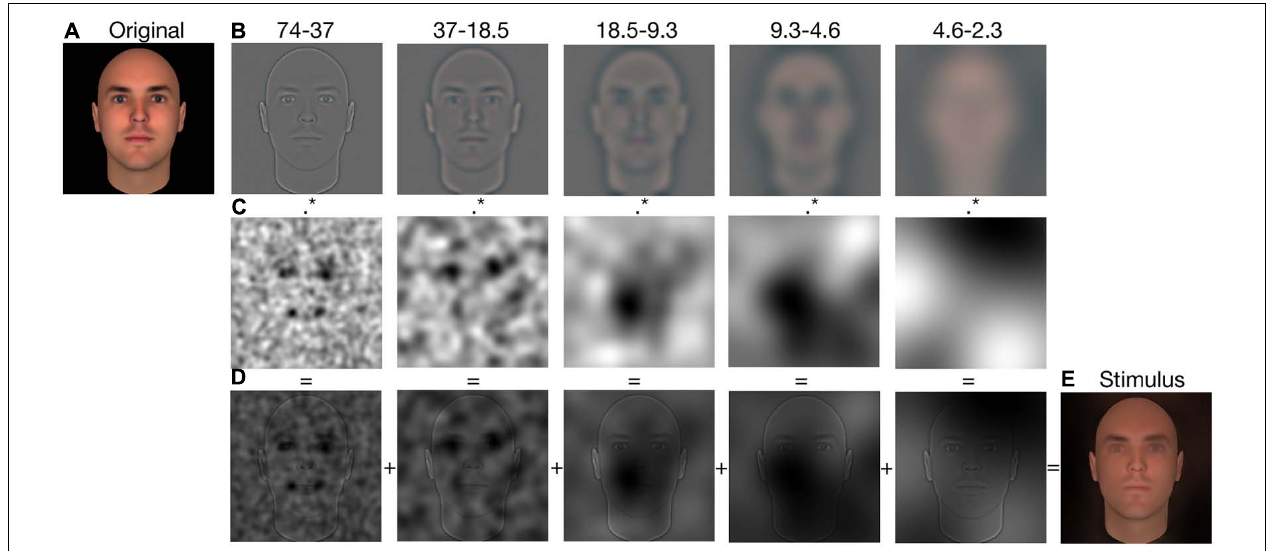
FIGURE 4 | Illustration of the stimulus-generation process for Experiment 2. Each original stimulus (A) was first decomposed into five spatial-frequency bandwidths (B) . Each bandwidth was then independently multiplied by the respective SCI (C) .The resulting visual information were summed across the five scales (D) to produce a filtered stimulus (E)